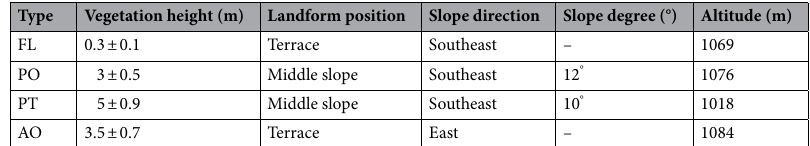
Experimental design and soil sampling. Three forestry types: Platycladus orientalis (Linn.) Franco for- est (PO), Pinus tabulaeformis Carr. forest (PT) and apple orchard (AO), as well as one farmland (FL) as a con- trol, were selected in this study, and two sites (spatial independent; Fig. 1) were sampled per vegetation type.